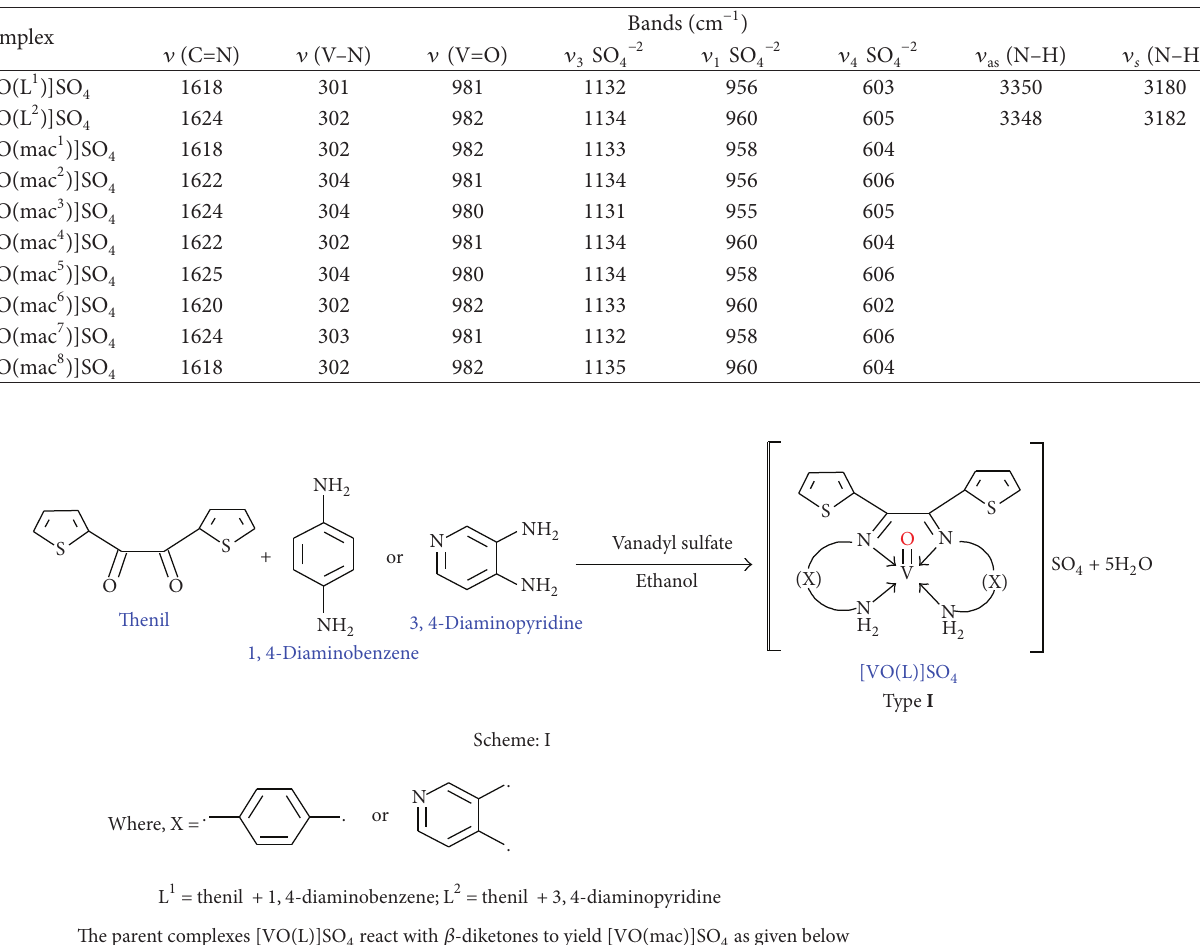
T 2: Infrared spectral bands of complexes.